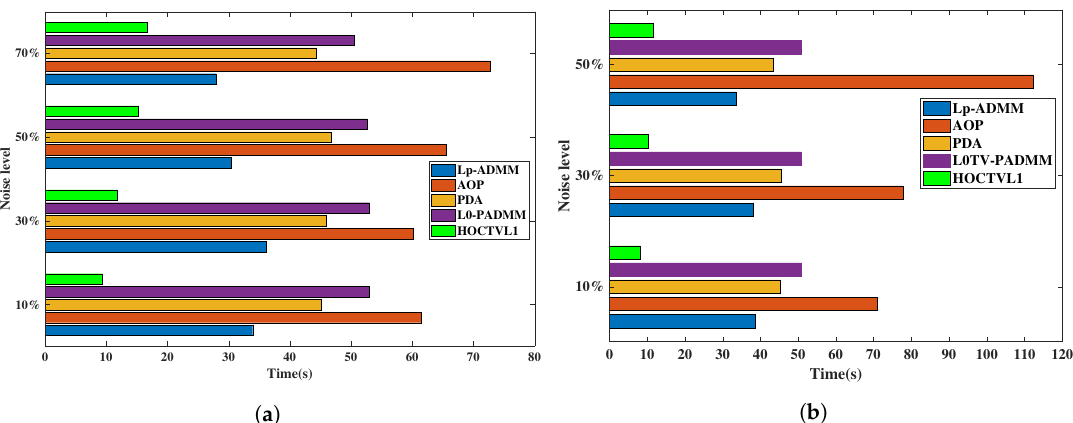
Figure 19. Running time of five methods for pepper corrupted by Gaussian blur and impulse noise. ( a ) Salt-and-pepper noise; ( b ) Random-valued